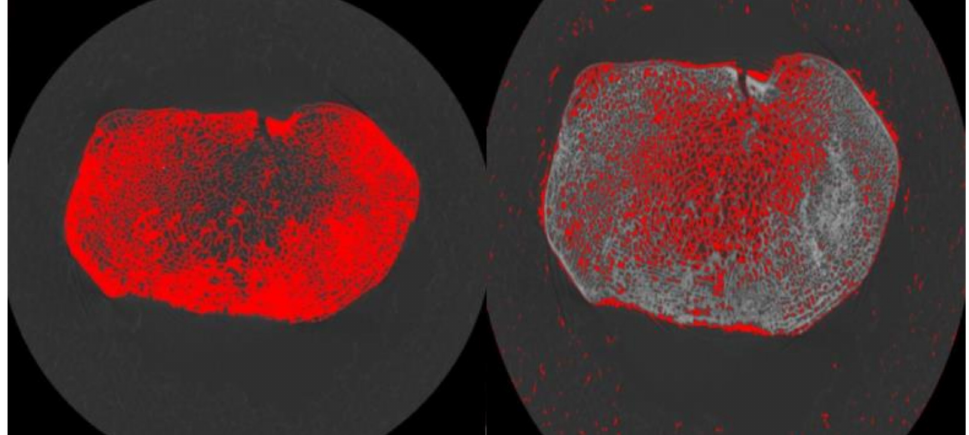
Figure 3. Left image: step one of separation script execution (highlighting bone). Note: bone material selected via threshold adjustments; 16.5-year-old tibia cross-section shown. Right image: step two of separation script execution (highlighting air space). Note: air space selected via a second set of threshold adjustments; 16.5-year-old tibia cross-section